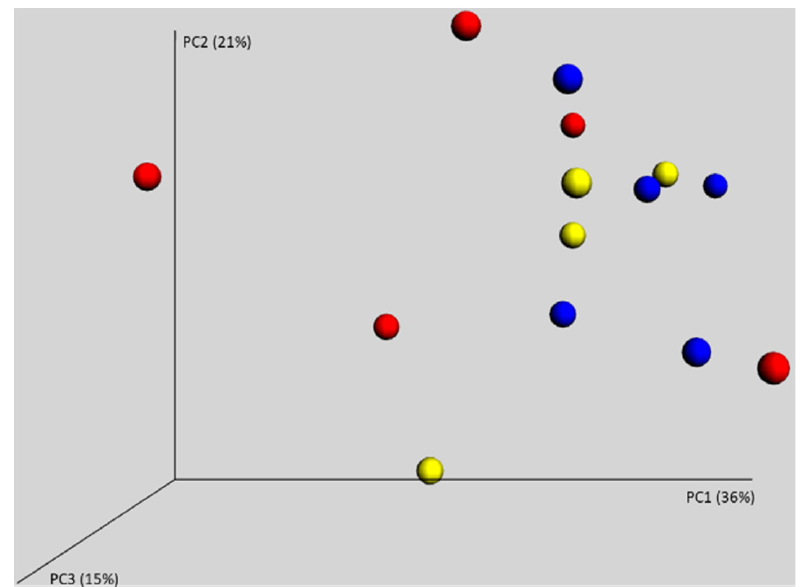
Figure 2. Weighted PCoA of caecal samples of chickens from three different parent flocks. No clustering according to origin of chickens defined by different colours was observed. Parents, therefore, did not play any role in the establishment of gut microbiota in the chickens in commercial produc- tion.